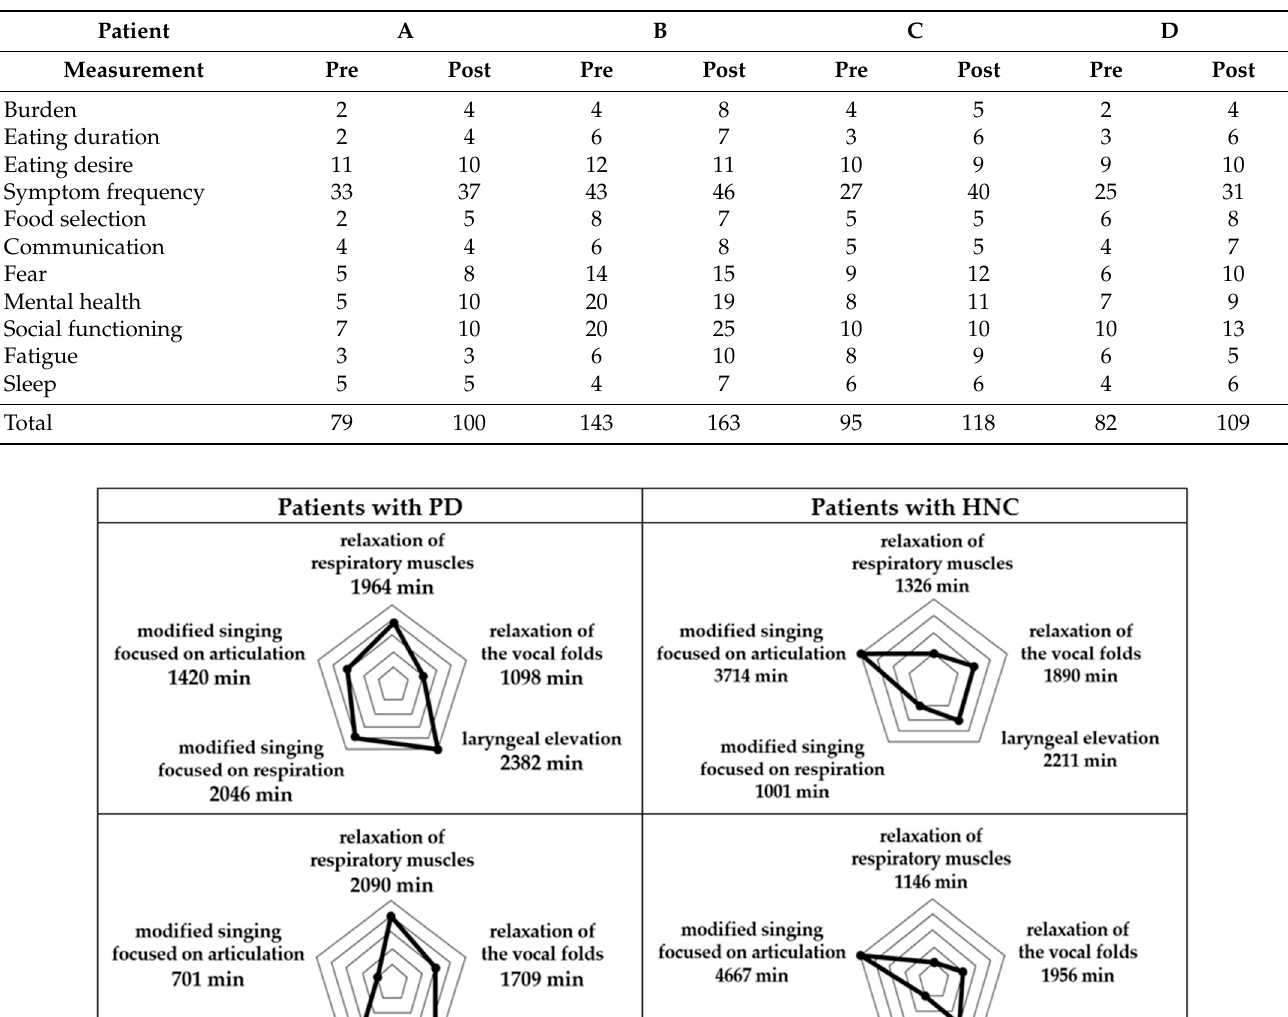
Table 4. Evaluation scores for SWAL-QOL.